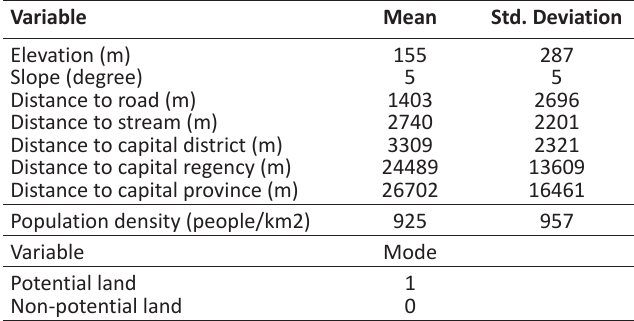
Table 1 . Descriptive statistics of each